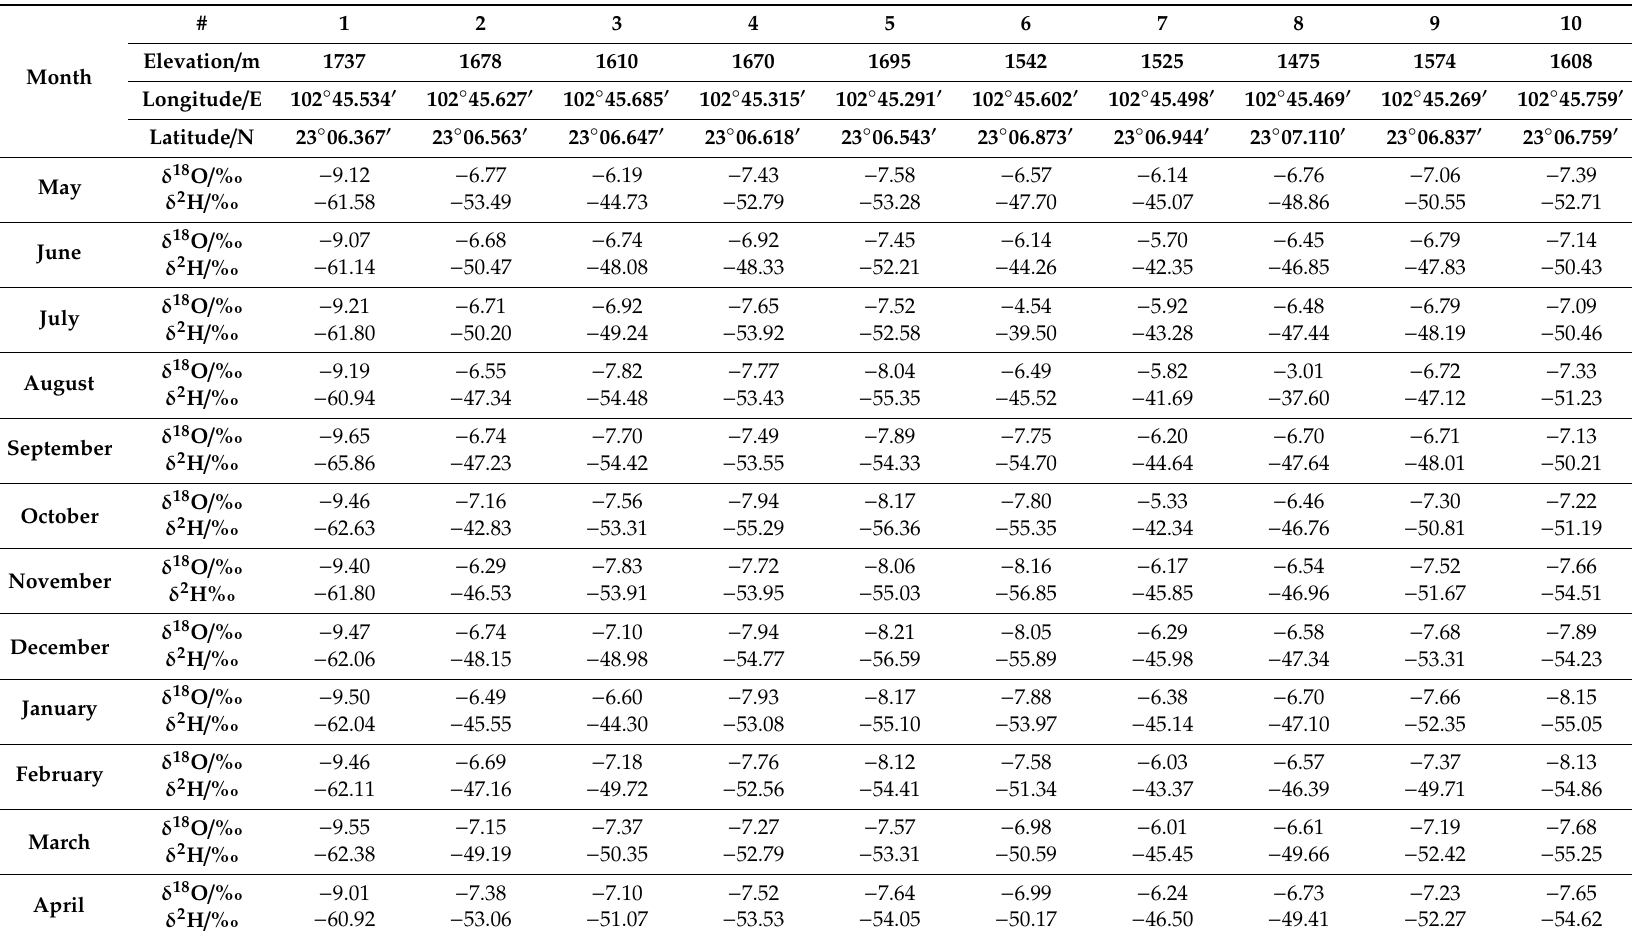
Table 2. δ 18 O and δ 2 H of groundwater at sampling points along the elevation